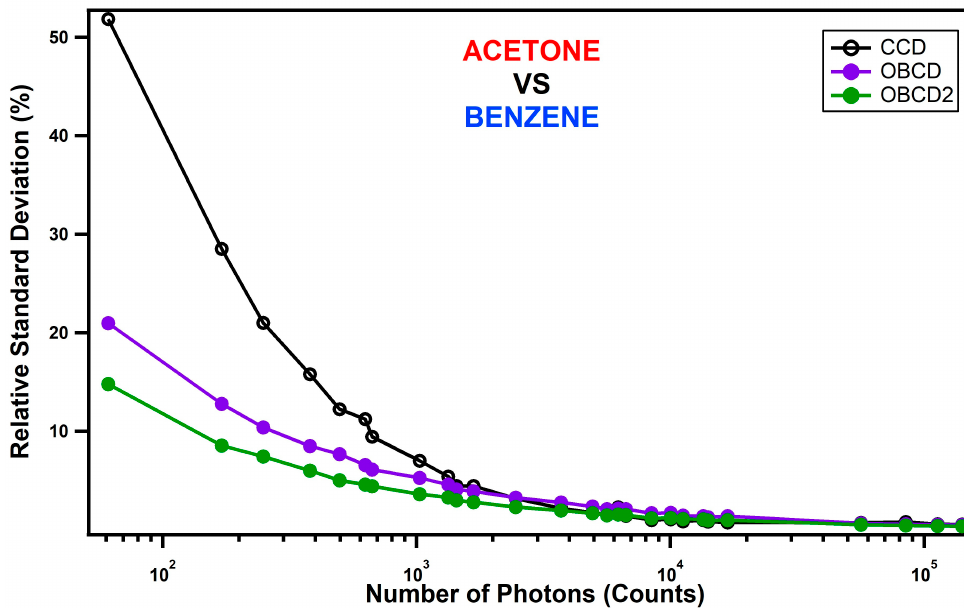
Figure 5. The figure compares the relative standard deviation in the classification using CCD, OBCD and OBCD2. The instrument was set to laser powers 30, 3, and 1 mW and counts were measured at nine integration times; 100, 80, 60,40, 10, 8, 6, 4, and 1 ms at each power.